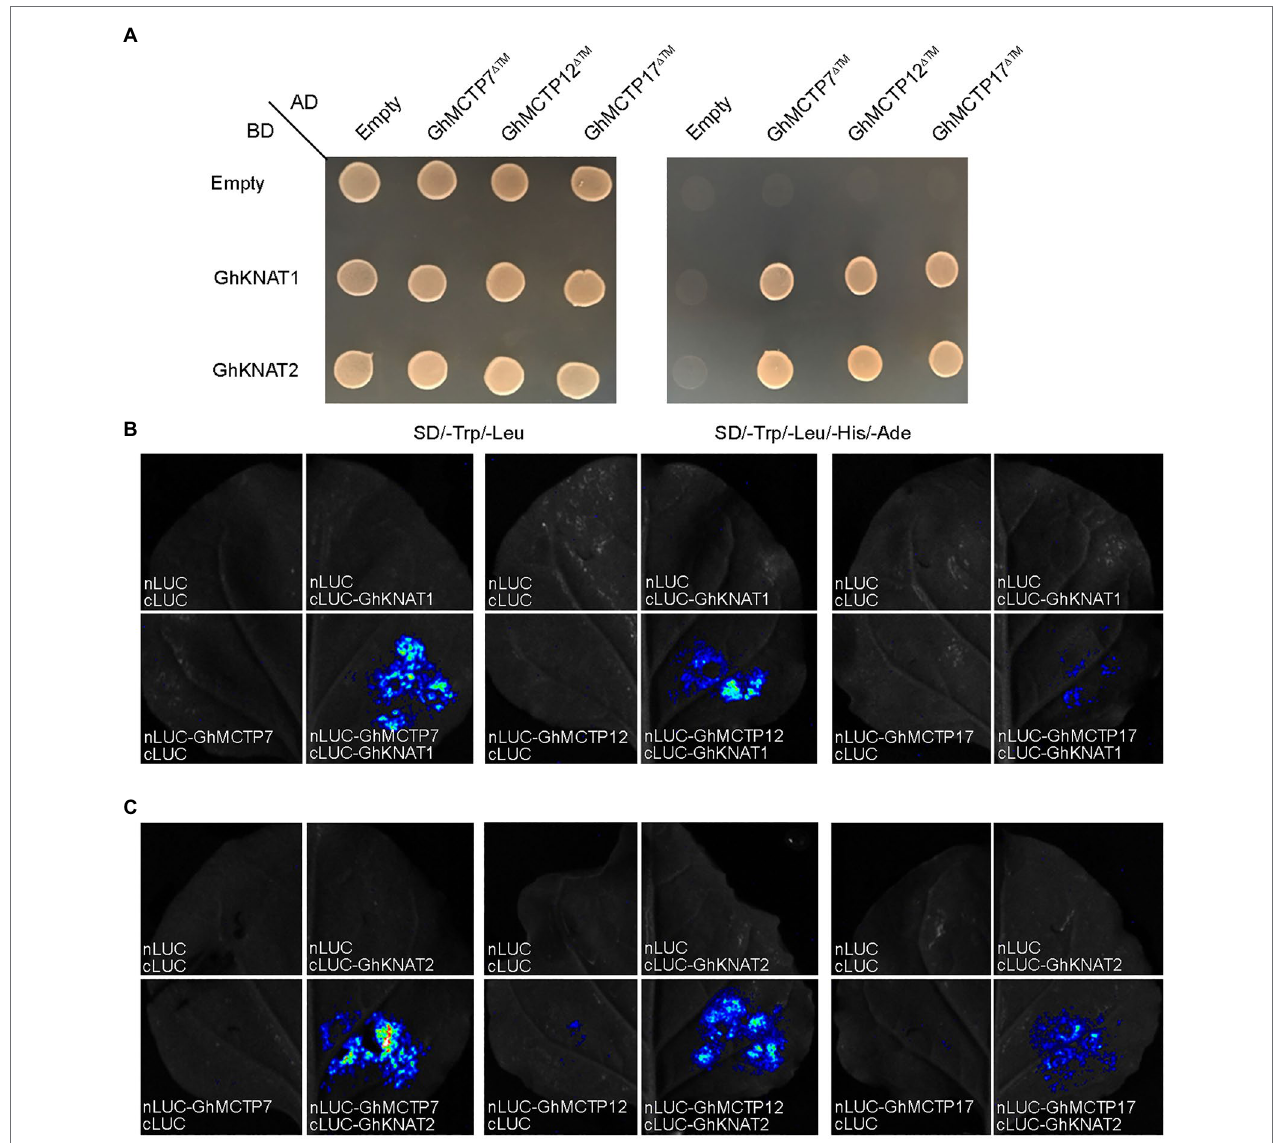
FIGURE 7 | GhMCTP7/12/17 interact with GhKNAT1/2. (A) Yeast two-hybrid assay showing the interaction between GhMCTP7/12/17 ∆ ™ and GhKNAT1/2. Transformed yeast cells were grown on SD -Ade/-His/-Leu/-Trp medium. (B,C) Luciferase complementation imaging (LCI) assays showing that GhMCTP7/12/17 interact with GhKNAT1 (B) and GhKNAT2 (C) in N. benthamiana leaves. Fluorescence signal intensities represent their protein interaction